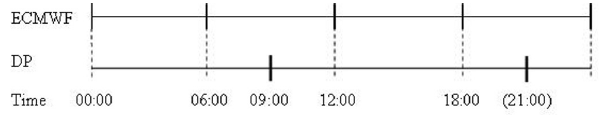
Fig. 2. Disaggregation of daily data to match the temporal resolu- tion of the ECMWF data. The above line indicates when ECMWF forecasts are issued and the bottom line the time of day when 24- and 12-hour data is